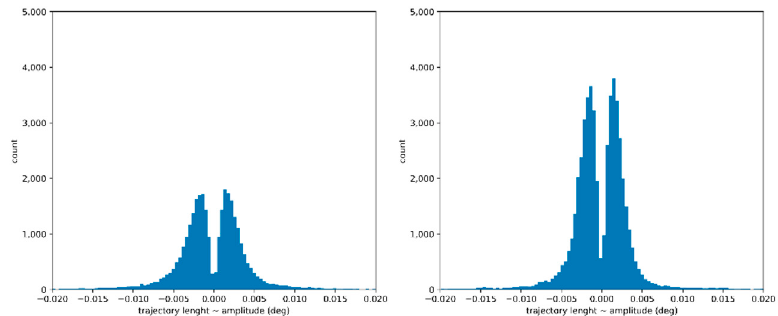
Figure A13. Histogram of the amplitude segments for the painting 2 dataset.